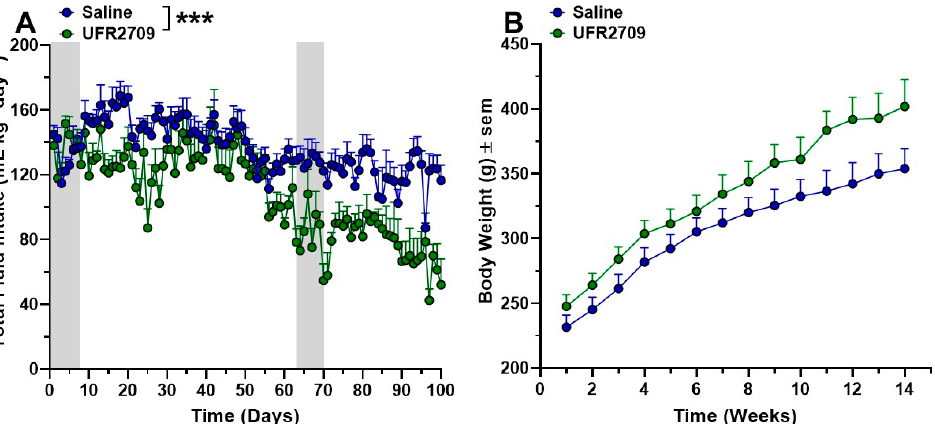
Figure 4. ( A ) Total fluid intake of 2.5 mg/kg of UFR2709 compared to the saline group. A two-way ANOVA with Bonferroni´s multiple comparison test between drug, saline, and days showed that UFR2709 produces significant differences in total fluid intake. ( B ) Data show the body weight of animal during the time of the experiment, all animal increases their body weight over the course of the experiment. Unpaired t -test was used to analyze the effect of UFR2709 treatment versus saline-treated group on the average ethanol consumption. *** p < 0.001.